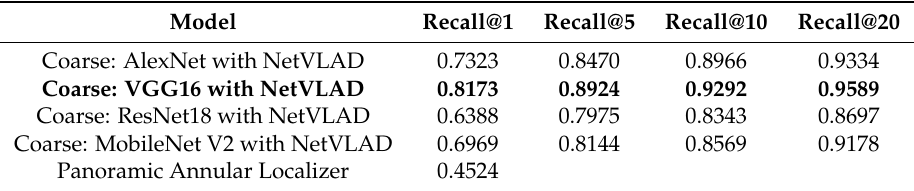
Table 4. Localization results of coarse stage on the Yuquan dataset [2]–Afternoon2 as query, Afternoon1 as database.